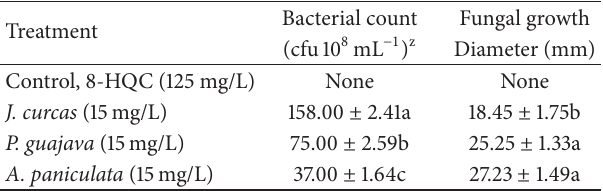
2% sucrose and 3% citric acid were added to each flower preservative solution. Data are means ± SE; 𝑛 = 10